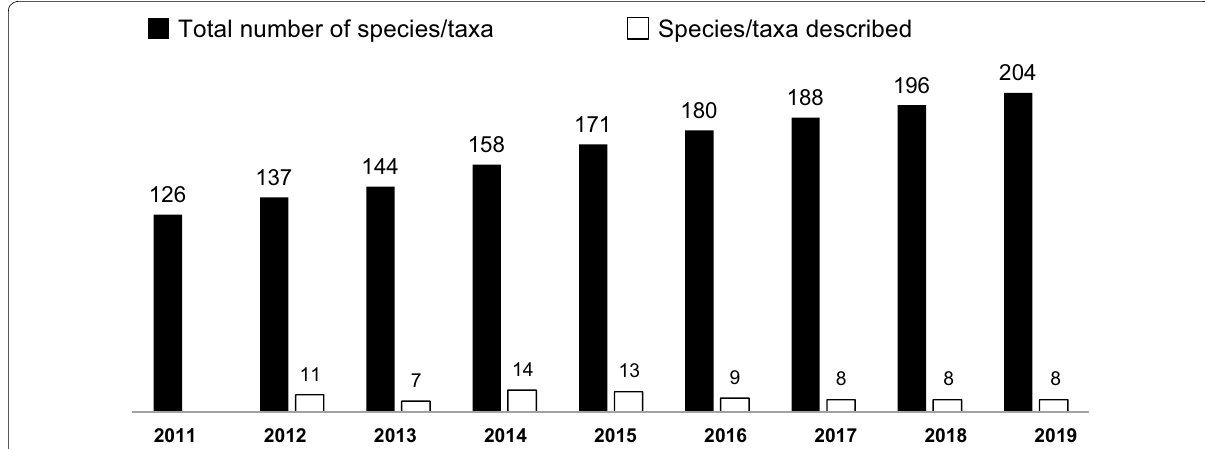
Fig. 1 Number of Primulina species/taxa published since 2011 (Xu et al. 2017; Hong et al. 2019; Kong et al. 2019; Li et al. 2019; Wen et al. 2019; Ye et al.